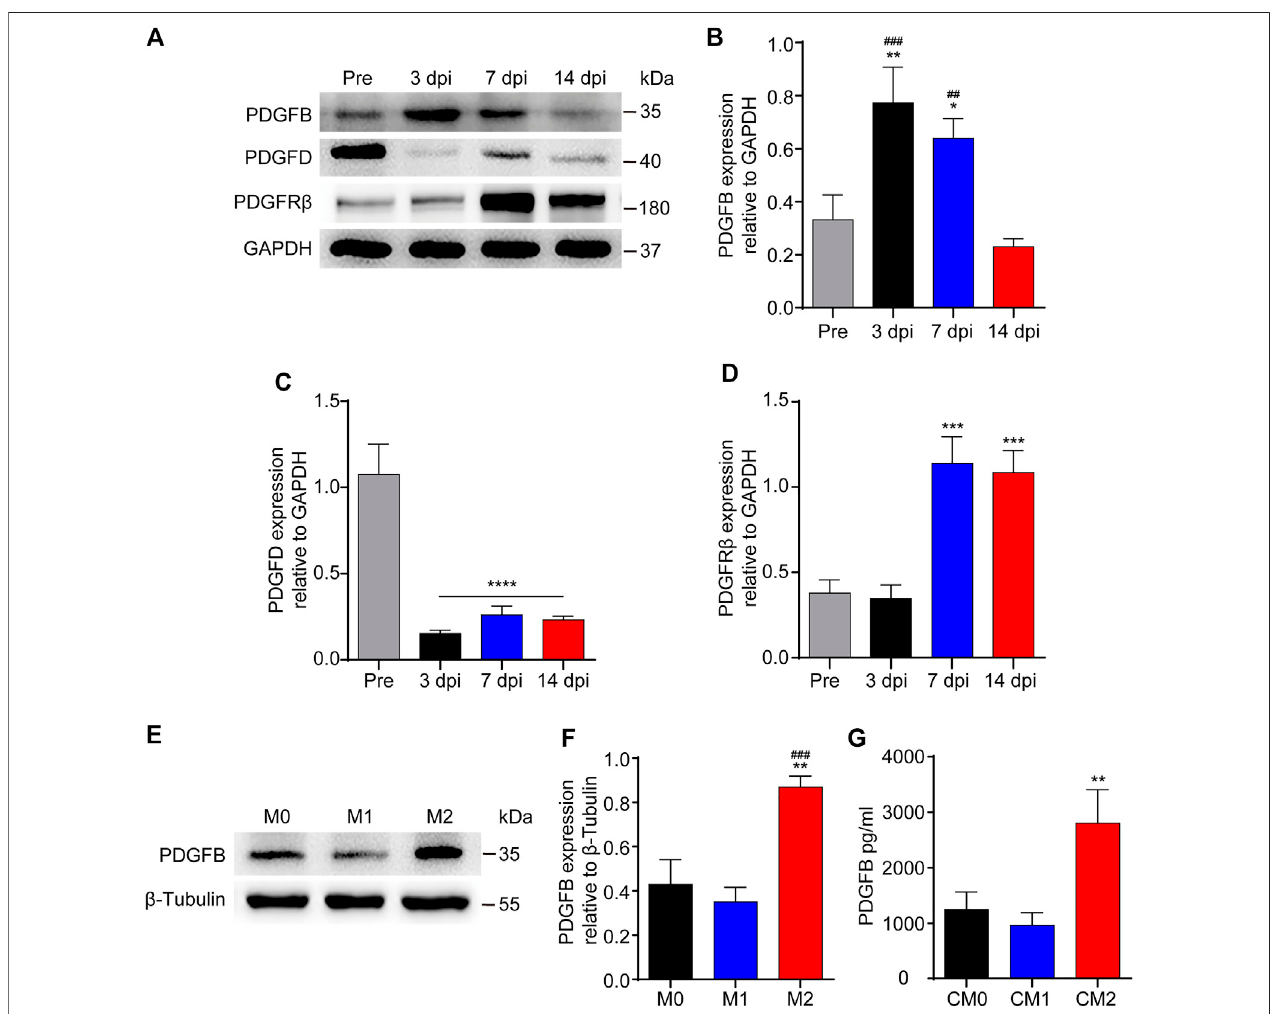
FIGURE 6 | The expression of PDGFB is signi fi cantly increased after SCI or macrophages M2 polarization. (A) Western blot was used to detect the expression levelsofPDGFB,PDGFDandPDGFR β before(Pre)andat3,7,and14 dpiintheinjurycoreofmice( n (cid:2) 5pergroup). (B) QuantitativeanalysisofPDGFBin (A) .Theblots werequanti fi edaspreviouslydescribed.** p < 0.01,* p < 0.05(3and7 dpivs.pre); ### p < 0.001, ## p < 0.01(3and7 dpivs.14 dpi). (C) QuantitativeanalysisofPDGFDin (A) . **** p < 0.0001 (3, 7, and 14 dpi vs. pre). (D) Quantitative analysis of PDGFR β in (A) . *** p < 0.001 (7, 14 dpi vs. pre and 3 dpi). (E) Western blot was used to detecttheexpression levelsofPDGFBinM0,M1orM2macrophages( n (cid:2) 5pergroup). (F) QuantitativeanalysisofPDGFBin (E) ,theblotswerequanti fi edaspreviously described, ** p < 0.01 (M2 vs. M0), ### p < 0.001 (M2 vs. M1). (G) ELISA was used to detect the concentration of PDGFB in CM0, CM1 or CM2 ( n (cid:2) 5 per group), The results were expressed as mean ± SD. ** p < 0.01 (CM2 vs. other